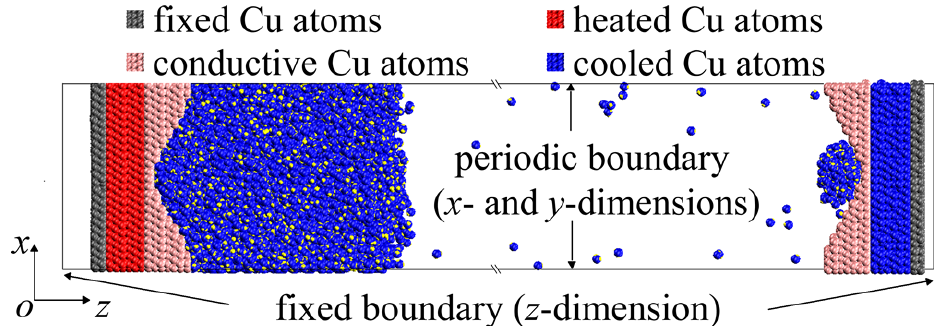
Figure 2. Arrangements of boundaries and reservoirs.